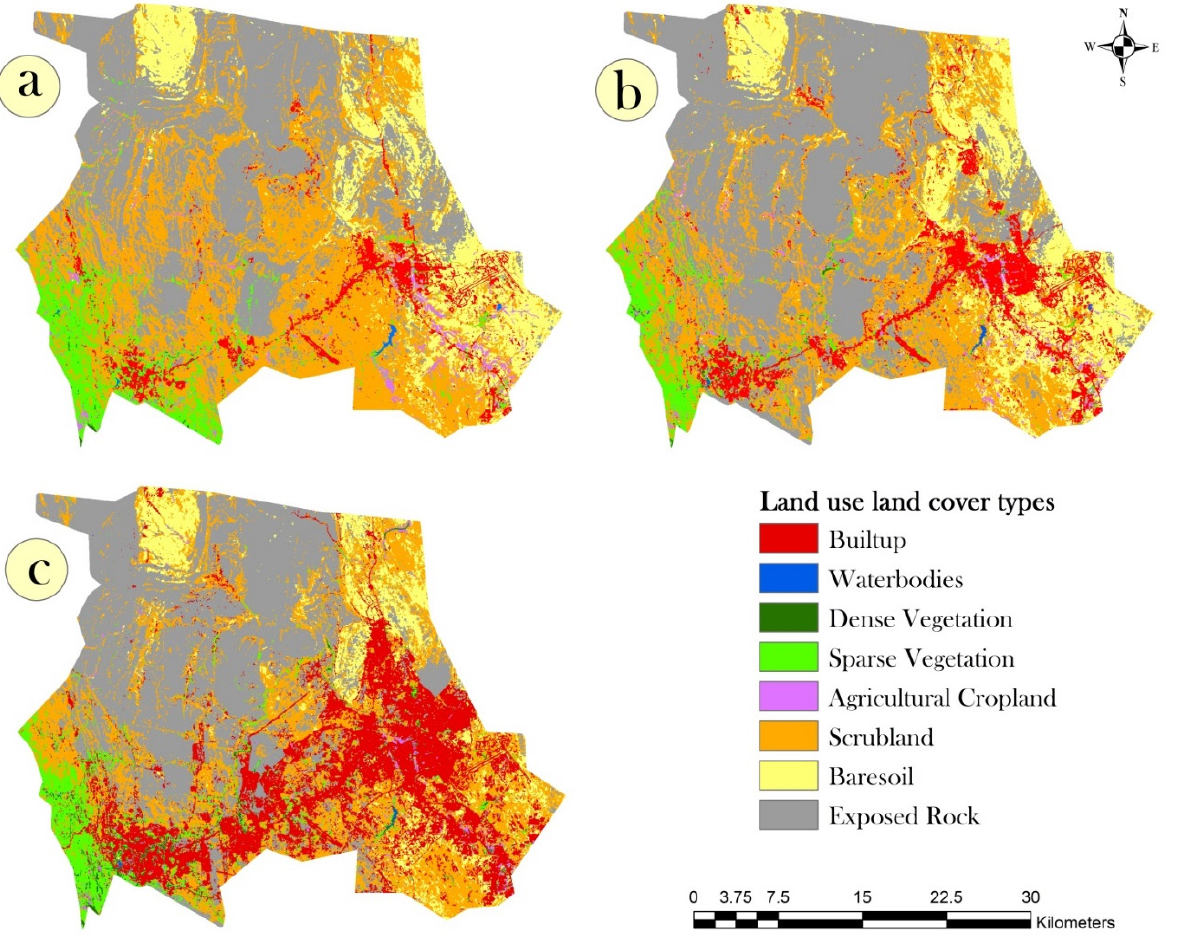
Figure 2. LULC classification for ( a ) 1990, ( b ) 2000, and ( c ) 2018 using SVM. A transitional probability matrix was used to compute the trend of LULC transfor- Table 1. LULC dynamics for the period of mation from each type to other LULC types. It denotes the likelihood of each cell of land-use types being transformed into another land-use type. The transitional probability matrix was constructed in the current study using the MOLUSCE plugin of QGIS (ver- sion 2.18.33) and the Markovian approach for the periods 1990–2000, 2000–2018, and 1990–2018 (Supplementary Tables S3–S5). The transitional probability matrix between the 1990 and 2018 LULC maps is shown in Supplementary Table S5. The diagonal bold values indicated that the probabilities remained constant over the period. A value of zero indicates that the land is not being used. The built-up area in the study area was the most consistent and stable land-use type, with 83.6% of the largest transition probability. Sim-